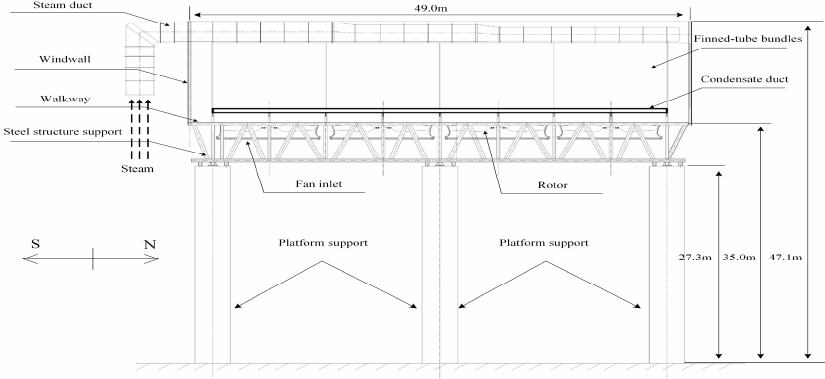
Figure 2. The side view of the